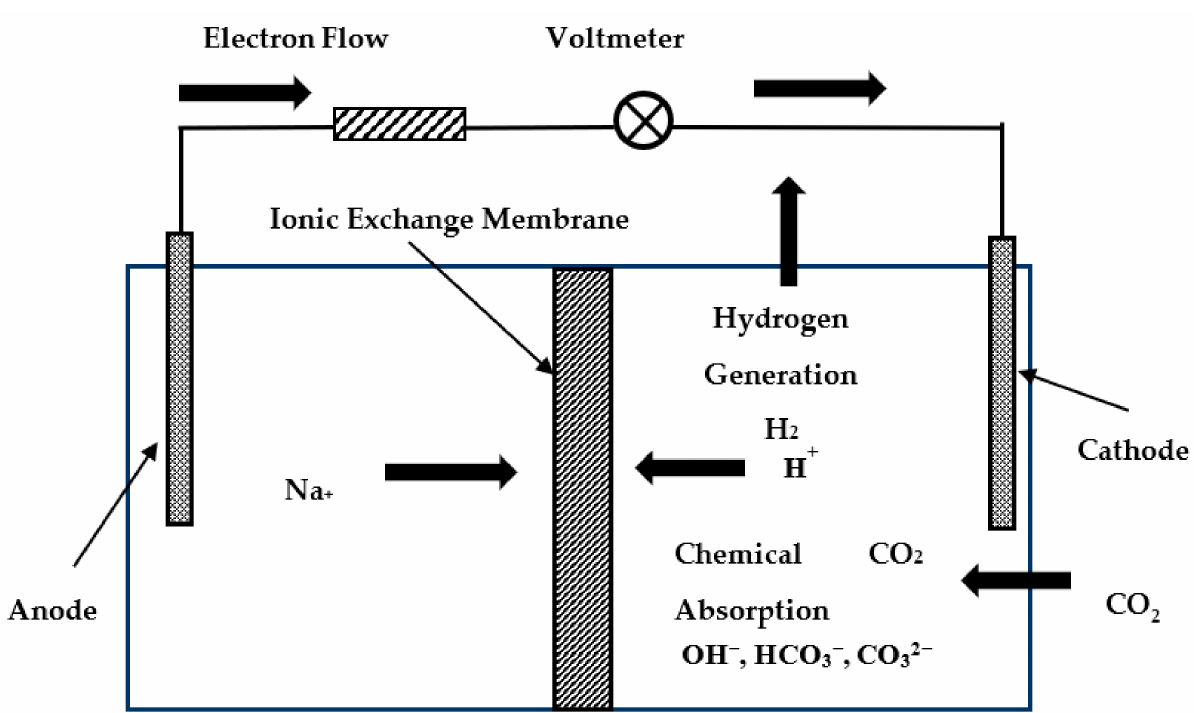
Figure 1. Electrochemical cell